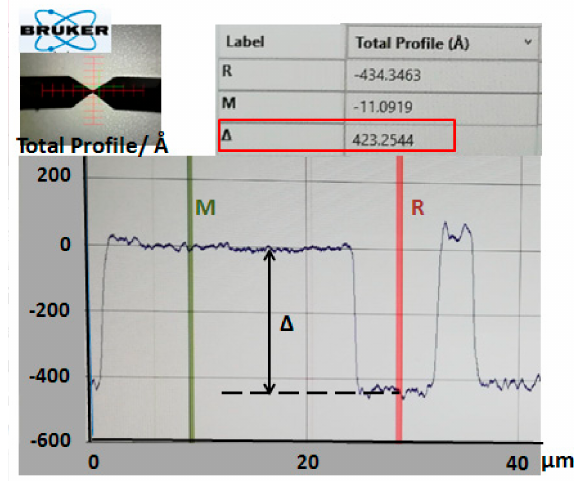
Figure 4. The surface profile of chrome layer.